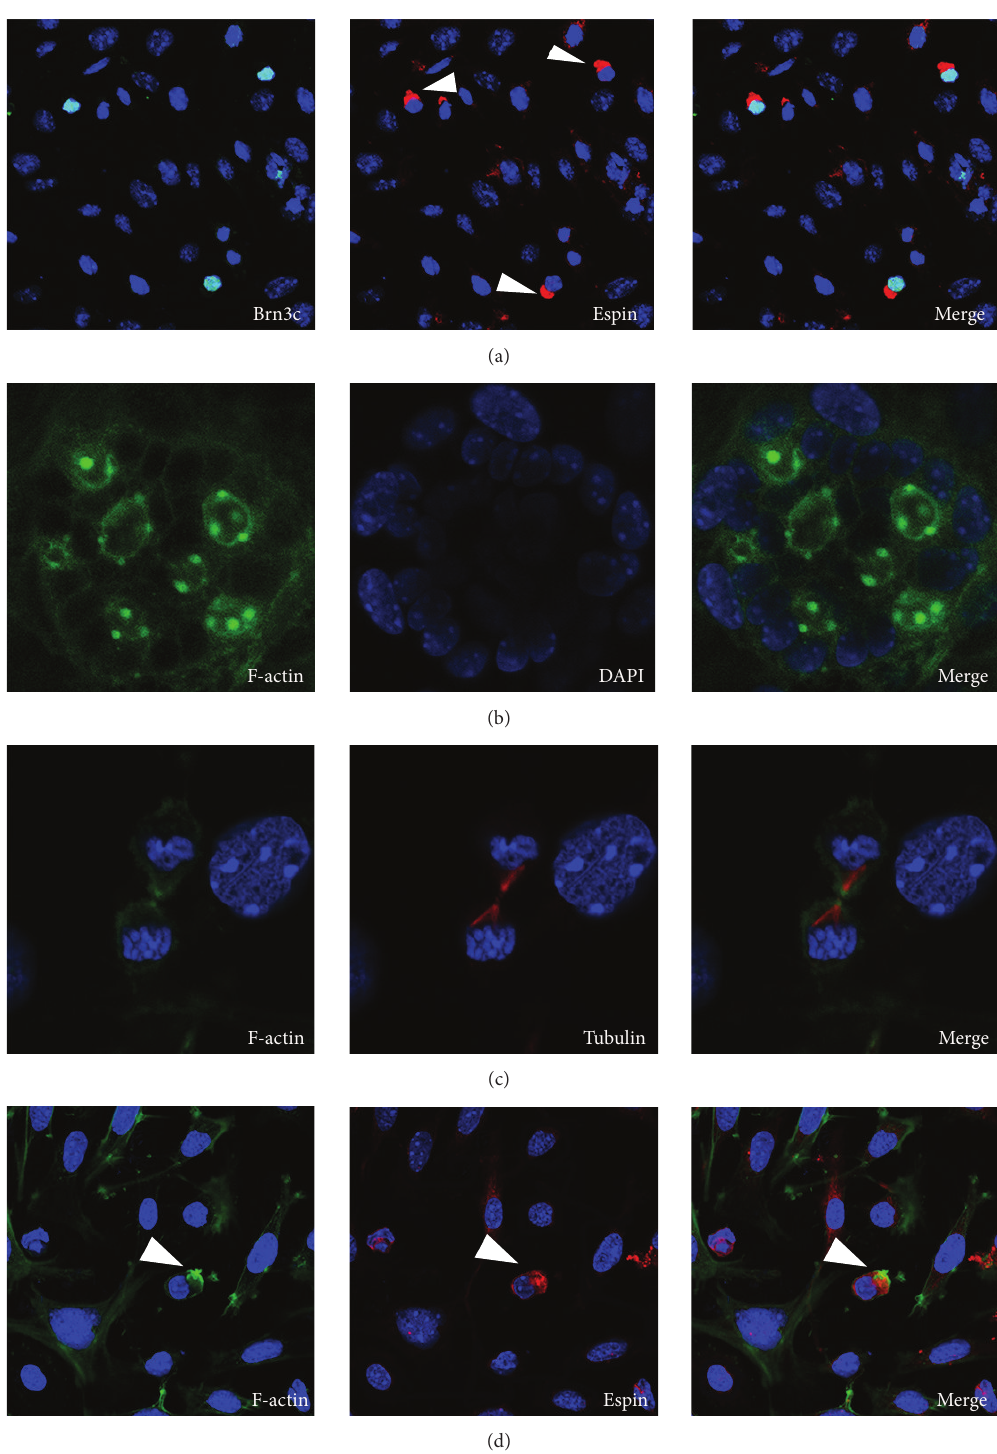
Figure 4: Hair bundle-like protrusions on cells differentiated on chicken utricle stromal cells. (a) The progenitor cells were plated on a layer of mitotically inactivated chicken utricle stromal cells (as shown in Figure 2(a)). After 7 days of differentiation, the Brn3c-positive cells (green) coexpressed the stereocilia marker Espin (red). Espin immunoreactivity was localized on one side of the presumptive hair cells (arrowheads in (a)). (b) When the progenitor cells were cultured on chicken stromal cells (as shown in Figure 2(a)), some cells displayed F-actin-rich protrusions. (c) Bundle-like structures protruding from the surface of the hair-cell-like cells showed colocalization of F-actin (green, left) and tubulin (red, center). Right: merged image of both labels. (d) The stereocilia-like extension was labeled with F-actin (arrowheads in (d), green, left) and Espin (arrowheads in (d), red, center). Right: merged image of both